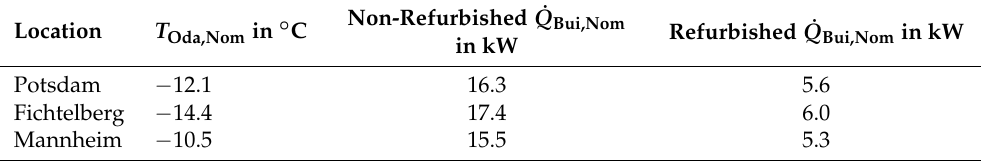
Table A1. Nominal heat demands and temperatures for the two buildings and three locations of the